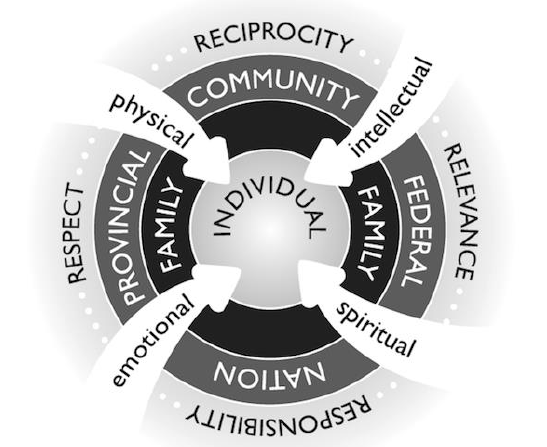
Figure 1. Indigenous Wholistic Framework.